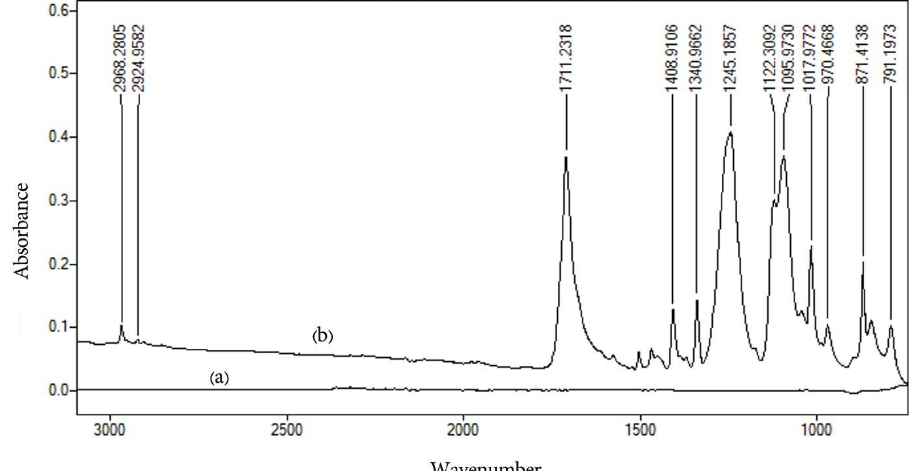
Fig. 5: ATR-FTIR absorbance spectra of (a) alumina substrate, (b) Alumina/PDMS hybrid nanofiltration membrane (M2).